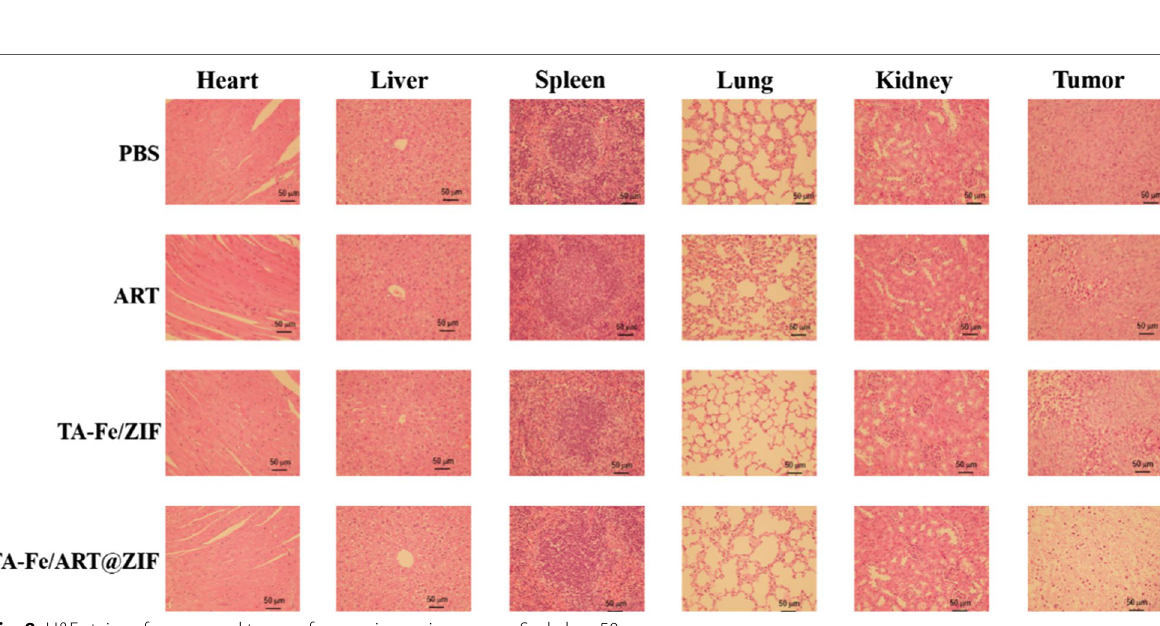
Fig. 8 H&E stains of organs and tumors from various mice groups. Scale bar: 50